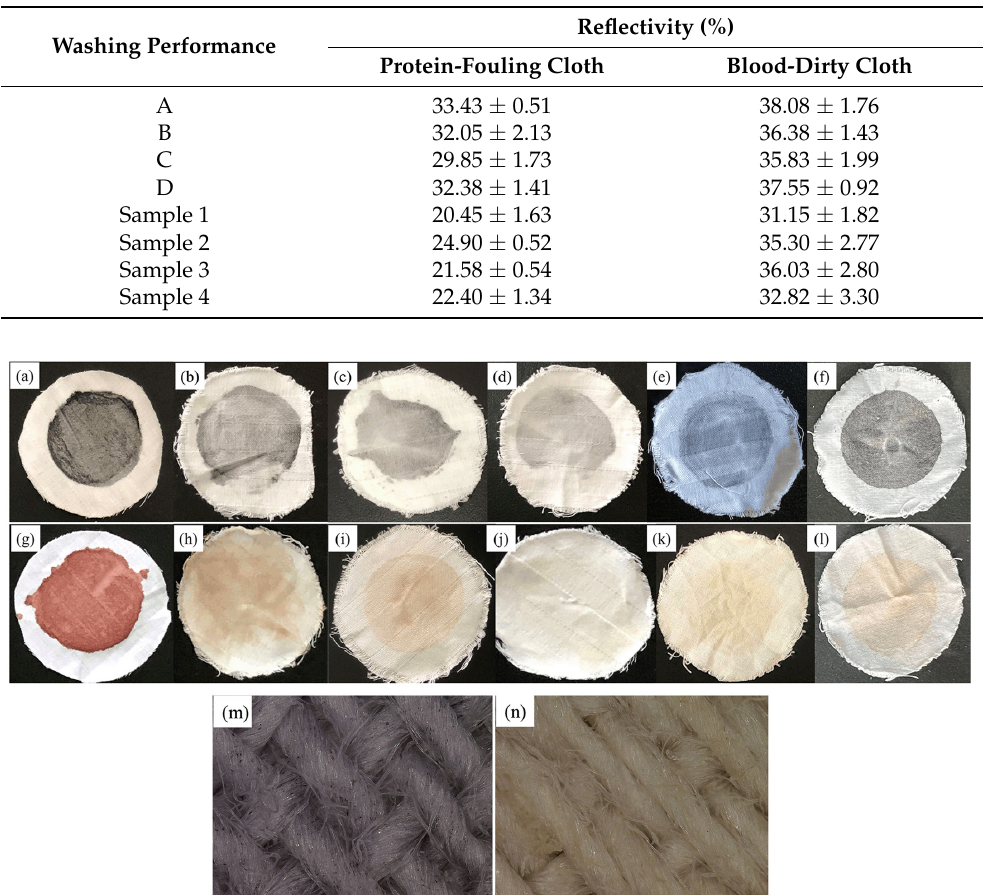
Table 7. Cleaning effect of protease liquid detergent samples and commercial liquid detergents on dirty cloth.